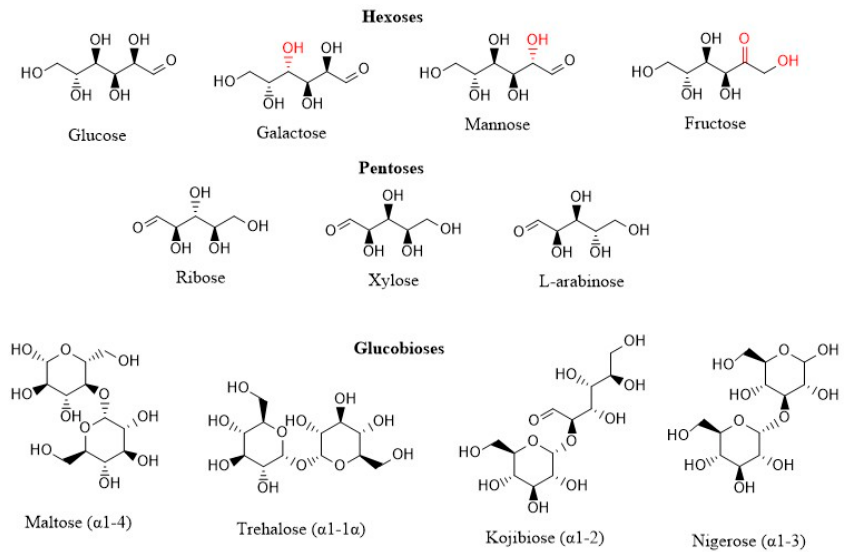
Figure 1. Chemical structure of sugars that were investigated in this study (ChemDraw). Differences in chemical structure compared to glucose are indicated in red (for hexoses). Glucobioses differ in chemical bond indicated behind the name of the molecule.